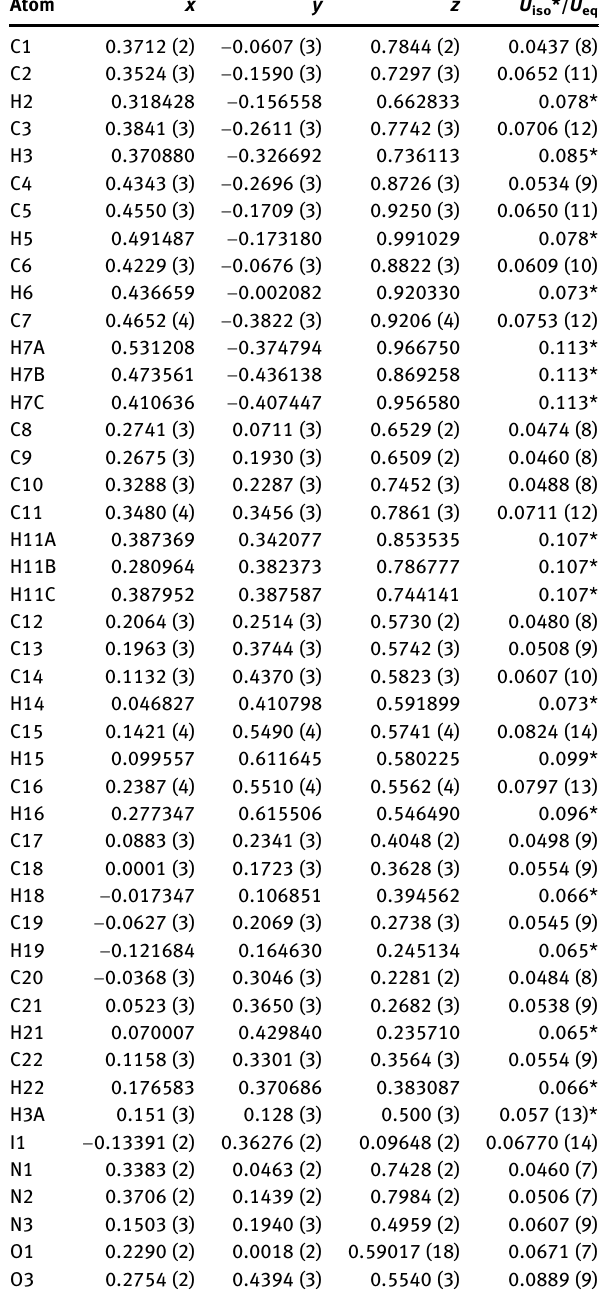
Table  : Fractional atomic coordinates and isotropic or equivalent isotropic displacement parameters (Å 